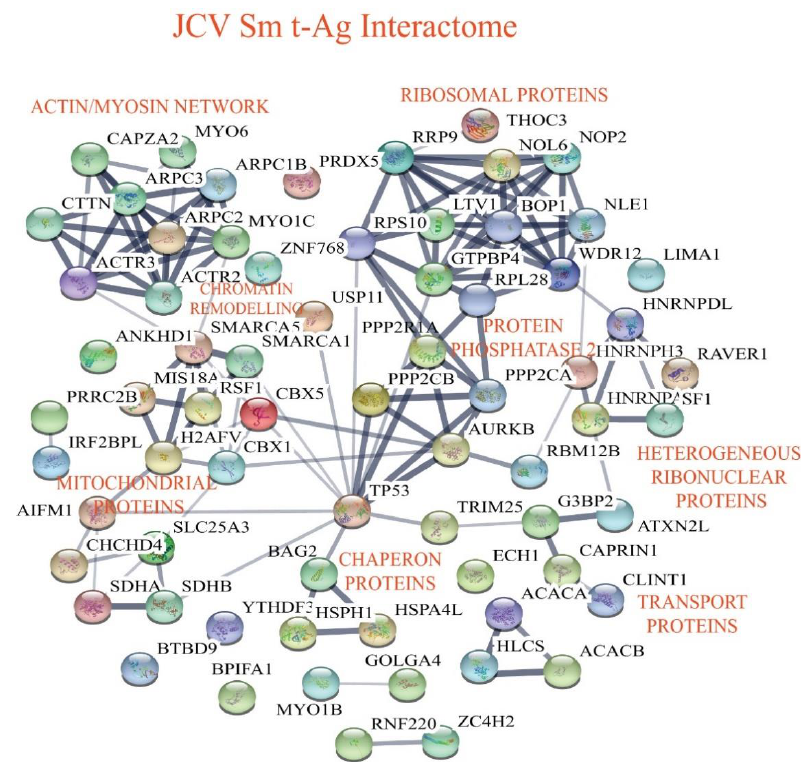
Figure 5. Analysis of the JCV Sm t-Ag interactome using “STRING database”. JCV Sm t-Ag primarily targets chromatin-remodeling proteins, mitochondrial proteins, PP2A complex proteins, chaperone proteins, Zn-binding proteins, heterogeneous ribonuclear proteins, ribosomal proteins, actin-myosin network, and others (Table